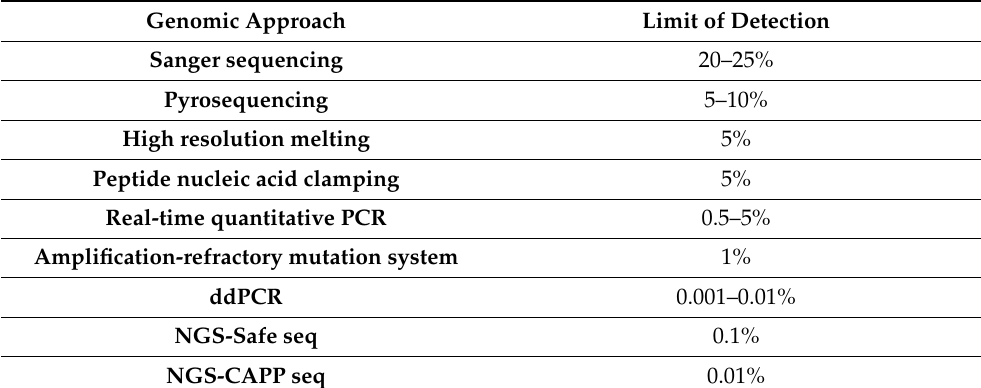
Table 2. Limit of detection of different genomic approaches to detect mutation